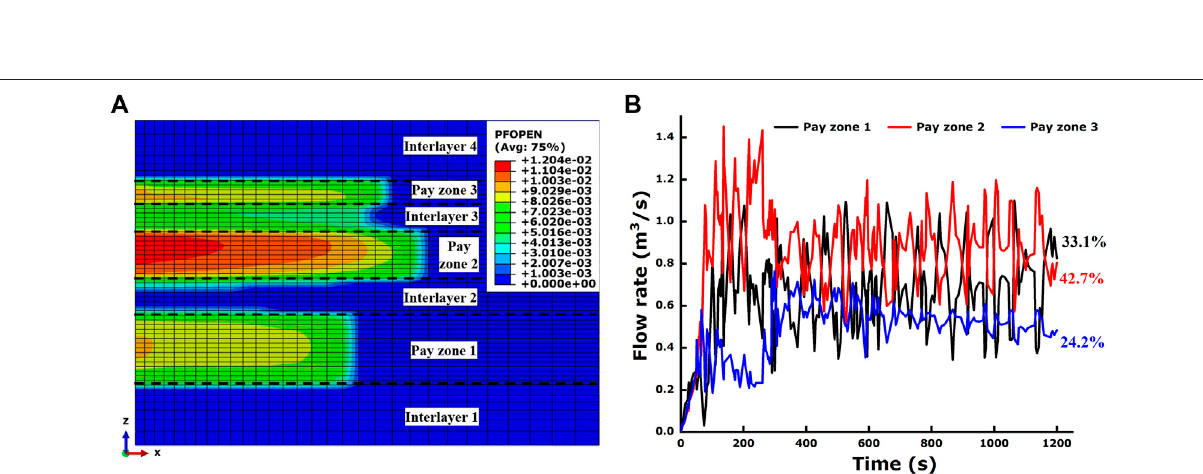
Frontiers in Earth Science |